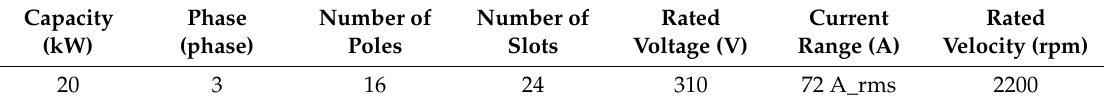
Table 1. Specifications of the dual rotor IPM